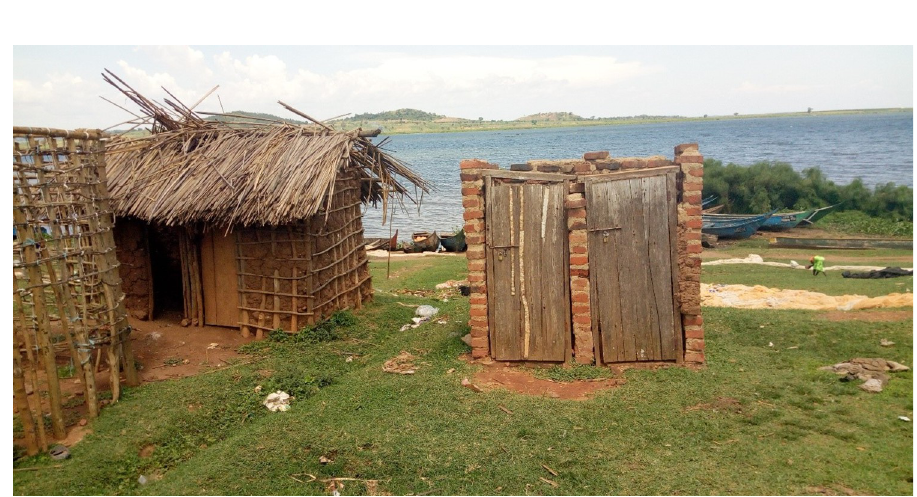
Fig 3. Examples of pit latrines in the studied communities.